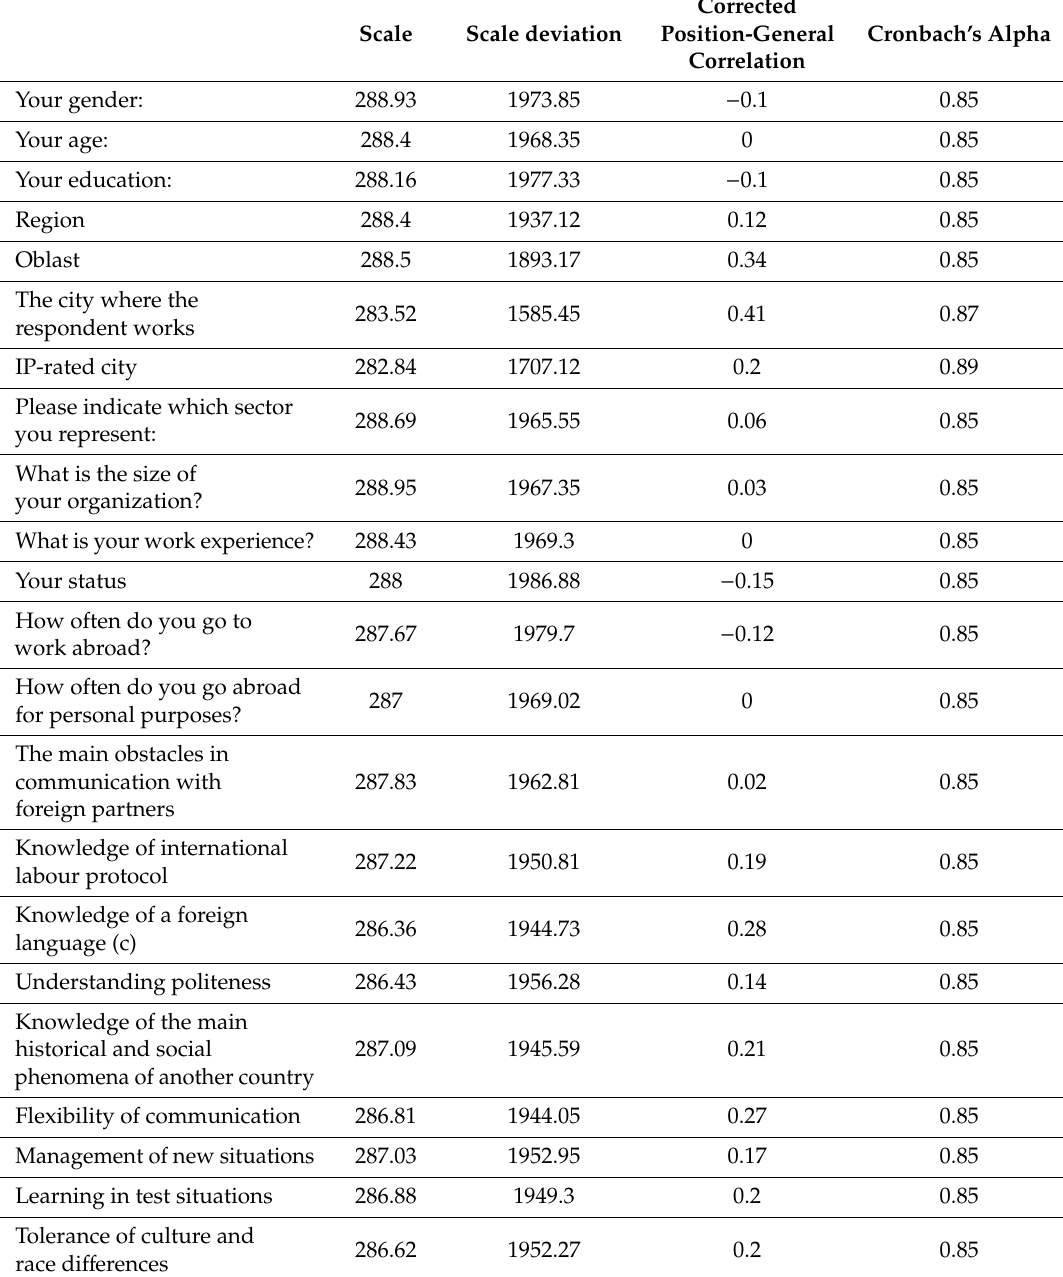
Table A2. Reliability indicators for the Cronbach’s Alpha coe ffi